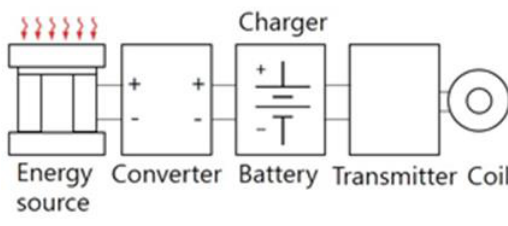
Figure 2. Typical energy node structure.